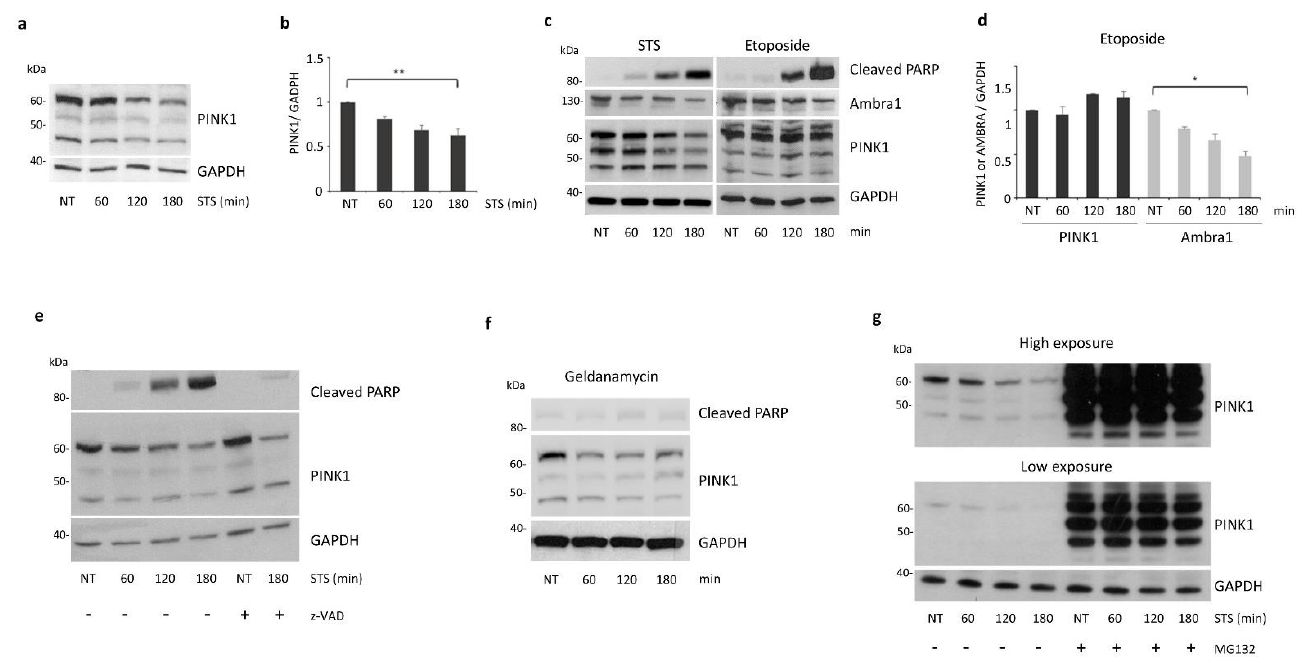
Figure 2. PINK1 protein levels decrease during STS treatment. ( a ) SH-SY5Y cells transiently overex- pressing PINK1-HA were treated either with STS (for 1, 2 and 3 h) or DMSO for 3 h (NT) and then processed for Western blotting by using an anti-PINK1 antibody (Novus). Equal loading was verified by GAPDH protein levels; ( b ) densitometric analysis showing a progressive decrease in full-length (FL) PINK1 levels during treatment; ( c ) SH-SY5Y cells co-expressing Ambra-Myc and PINK1-HA were treated with STS or etoposide at the indicated times and analyzed by immunoblotting. A similar increase in cleaved PARP levels was observed after STS or etoposide exposure; however, even if Ambra protein levels decreased in both experimental conditions, FL-PINK1 levels decreased significantly only upon STS treatment; ( d ) densitometric analysis of PINK1 and Ambra proteins in SH-SY5Y cells treated with etoposide; ( e ) SH-SY5Y cells transiently expressing PINK1-HA were treated with STS or with both the caspase inhibitor z-VAD-fmk and STS for 3 h. Immunoblot analysis with the anti-PINK1 antibody showed a comparable decrease in FL-PINK1 levels for 3 h of STS or z-VAD-fmk/STS treatment, excluding an involvement of caspase in PINK1 degradation; ( f ) lysates from SH-SY5Y cells, treated with Geldanamycin (Hsp90 inhibitor) at the indicated times, were analyzed by immunoblotting with the anti-PINK1 antibody to monitor FL-PINK1 protein levels; ( g ) SH-SY5Y cells transiently expressing PINK1-HA were treated with STS ± MG132 (proteasome in- hibitor). Immunoblot analysis with the anti-PINK1 antibody showed a strong stabilization of HA- PINK1 after MG132 treatment. *p ≤ 0.05, **p ≤ 0.01.